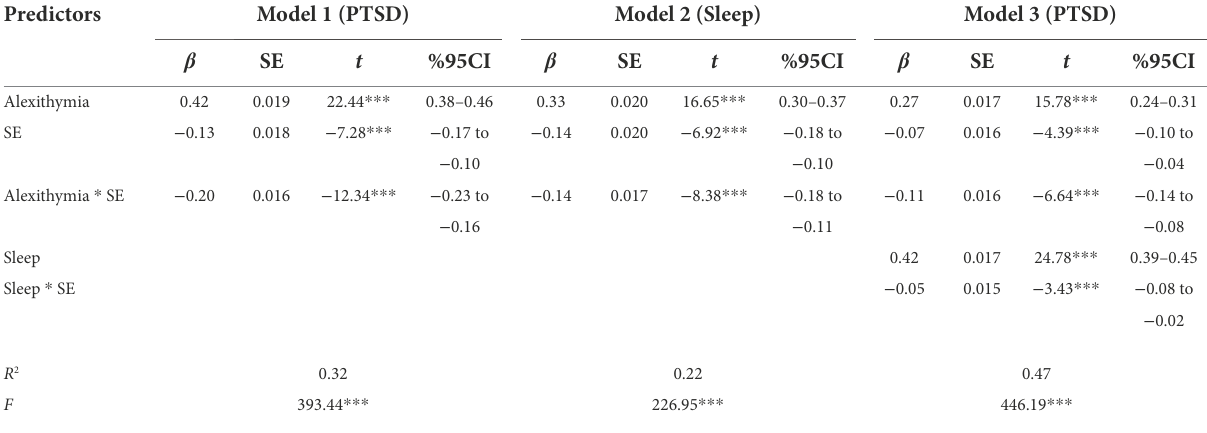
TABLE 4 Moderated mediation effect of alexithymia on PTSD ( N = 2,485).